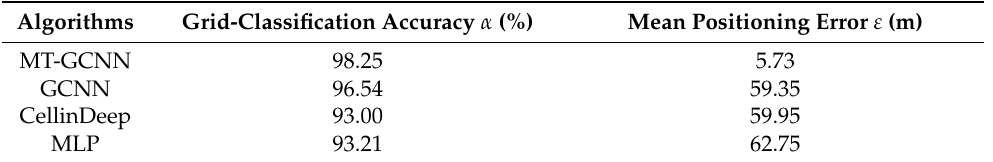
Table 1. The comparison of grid-classification accuracy and mean positioning error with different algorithms when M = 1 and N =